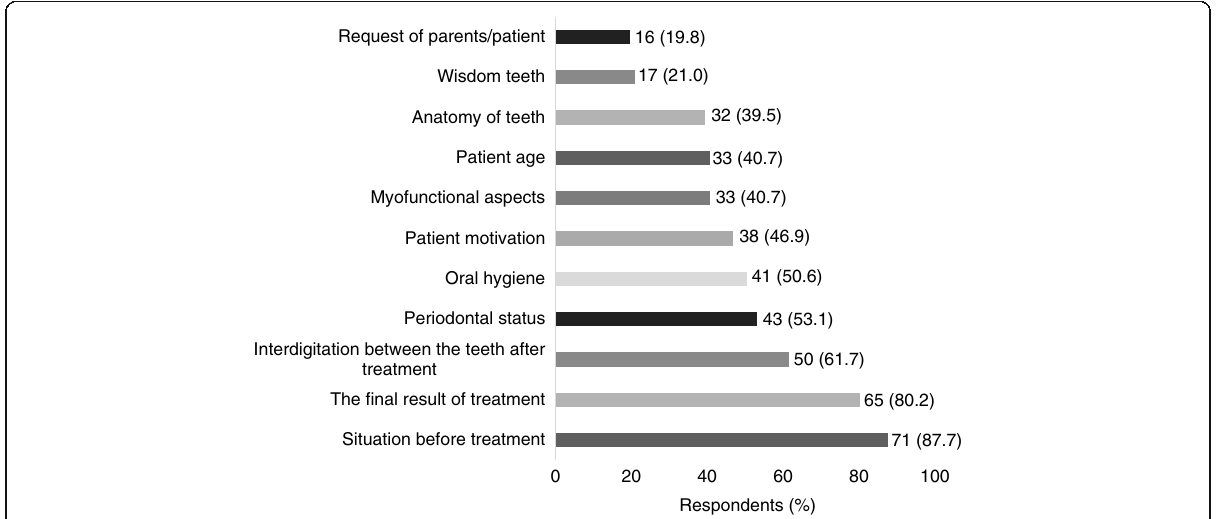
Fig. 1 Absolute numbers and percentage of the respondents who noted the factors influencing their choice of